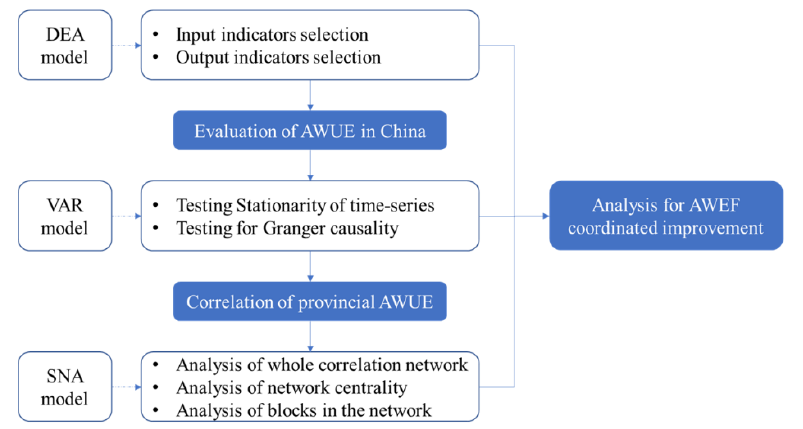
Figure 1. Technical route for analysis of spatial correlation network of agricultural water use efficiency (AWUE).